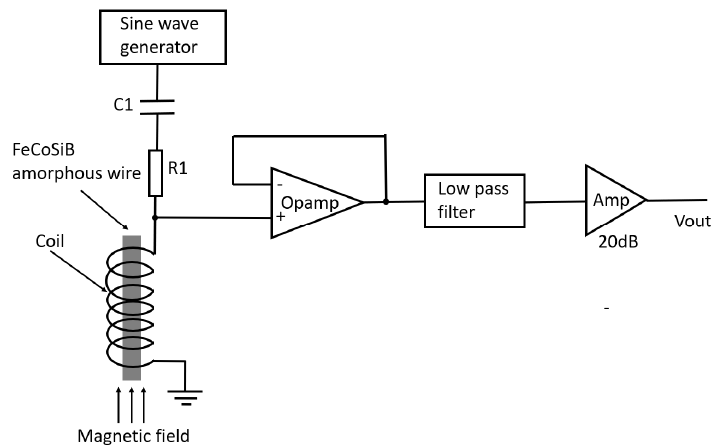
Figure 9. Schematic diagram of the magnetic sensor using the nonlinear effect of the coil with amorphous wire core.